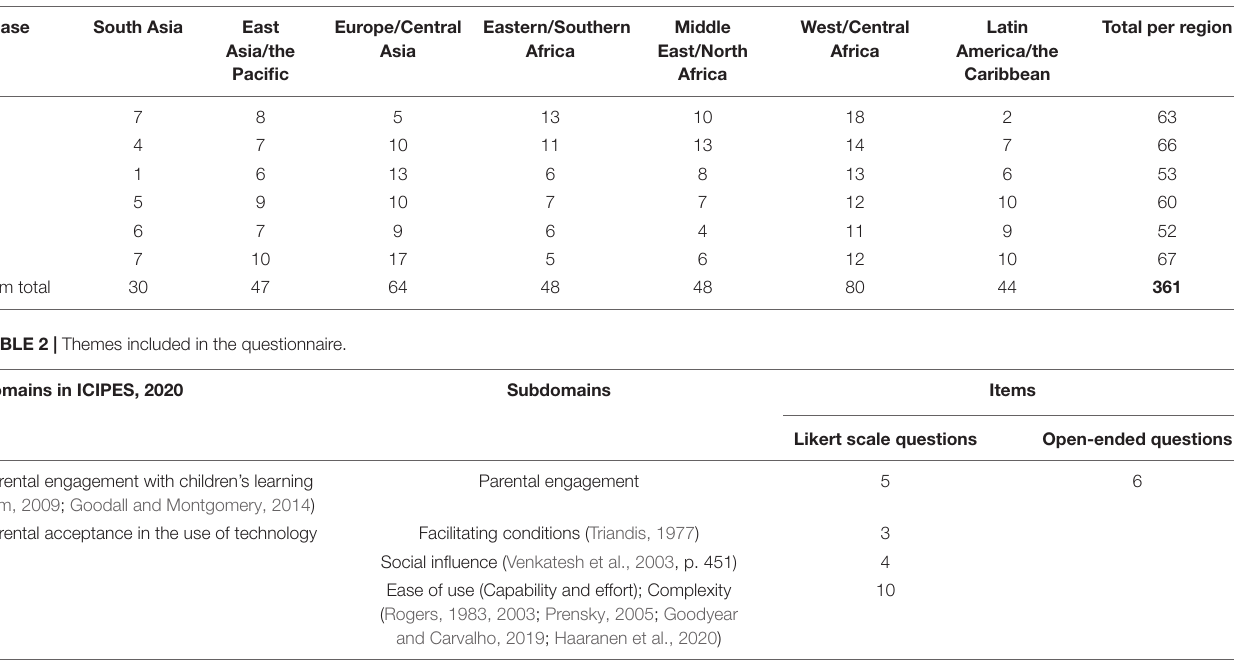
TABLE 1 | MICS surveys by phase and territory.